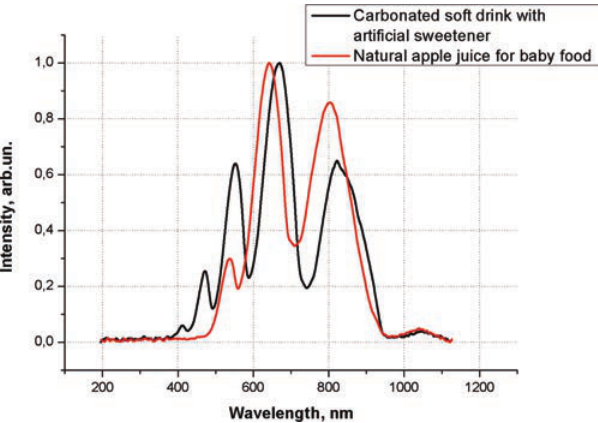
Fig. 5. Normalized transmission spectra of the PCW samples, ¯lled up with natural apple juice for baby food and carbonated soft drink with arti¯cial sweetener.